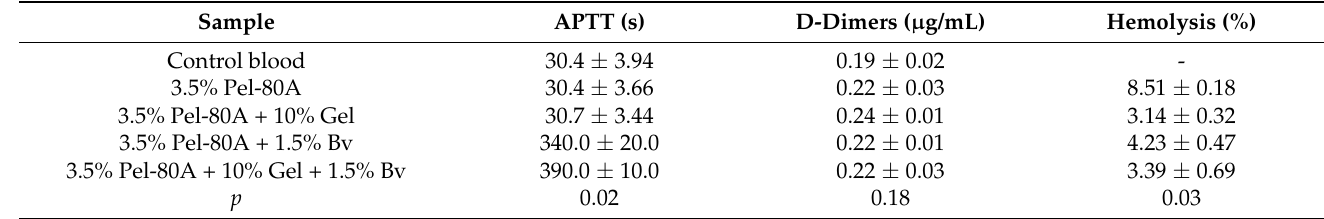
Table 2. Hemocompatibility of electrospun